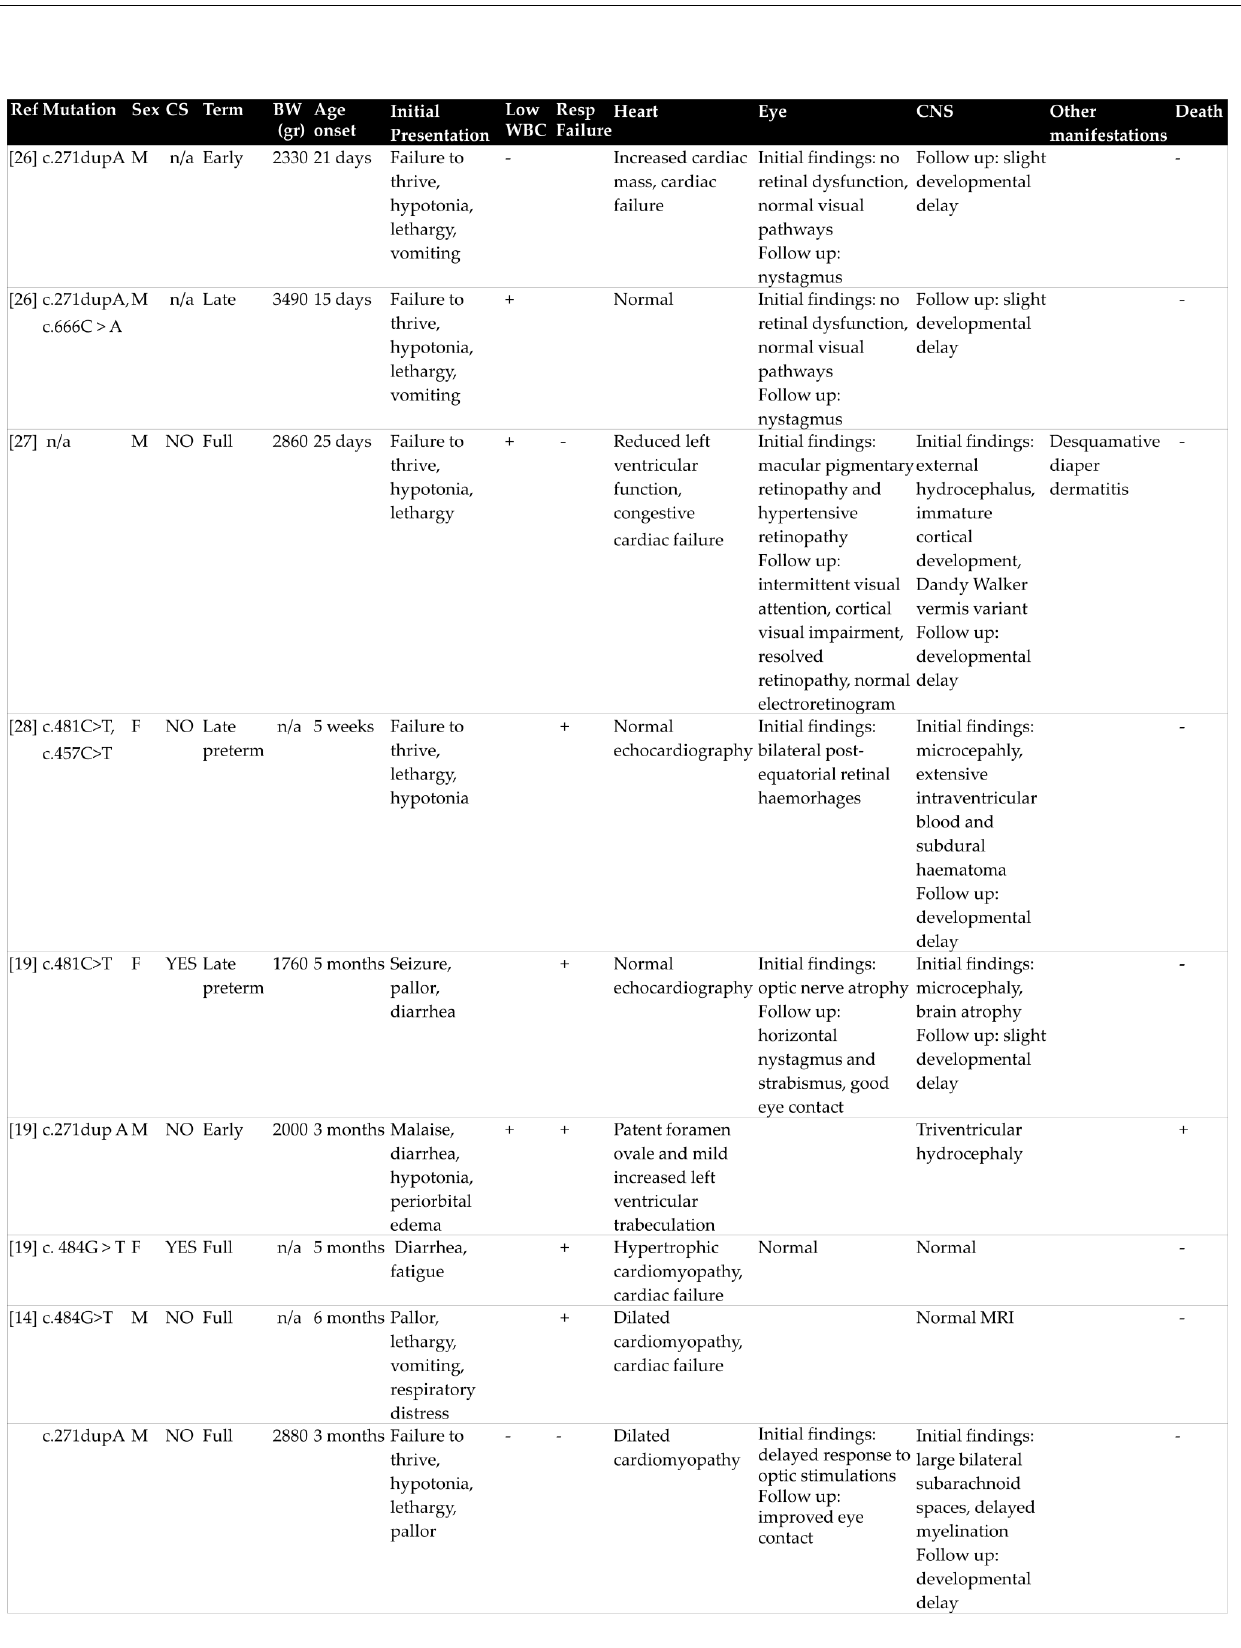
Figure 3. Dermographic parameters, perinatal history, initial presentation, extra-renal manifestations, type of MMACHC mutation and outcome of patients with early-onset cyanocobalamin C defect and hemolytic uremic syndrome. BW: birth weight, CNS: central nervous system, CS: consanguinity, WBC: white blood cells, MRI: magnetic resonance imaging, Resp failure: respiratory